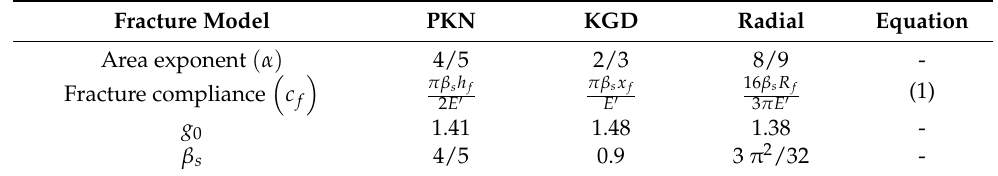
Table 2. Fracture geometry